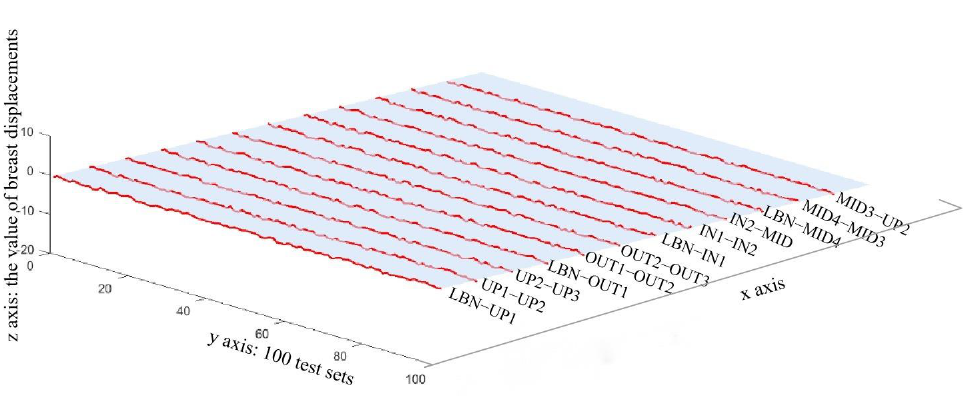
Figure 4. 3D illustration of MAPE result predicted by PSO-BP ANN model.